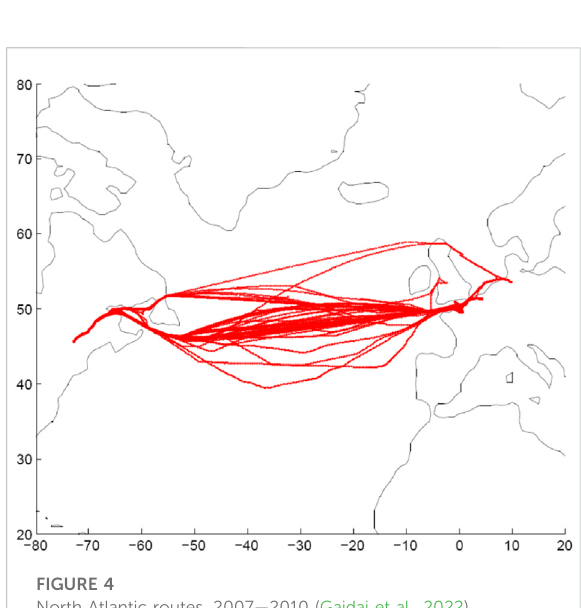
FIGURE 4 North Atlantic routes, 2007 — 2010 (Gaidai et al.,